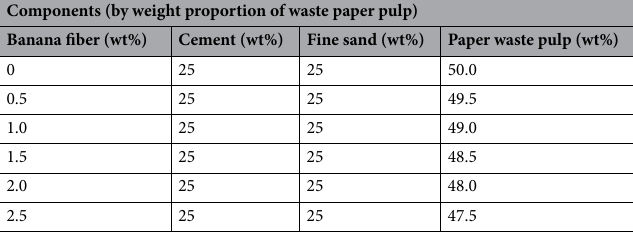
Table 1. Composition mix.